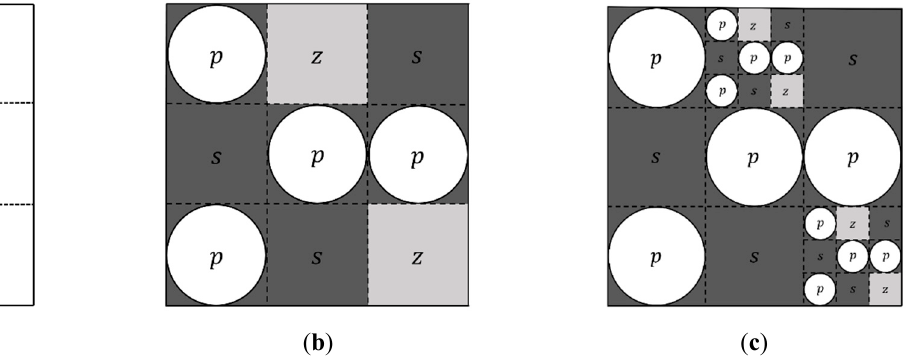
Figure 1. Construction process of PSF model with circular-based pores: ( a ) 0th generation; ( b ) 1st generation; ( c ) 2nd generation.